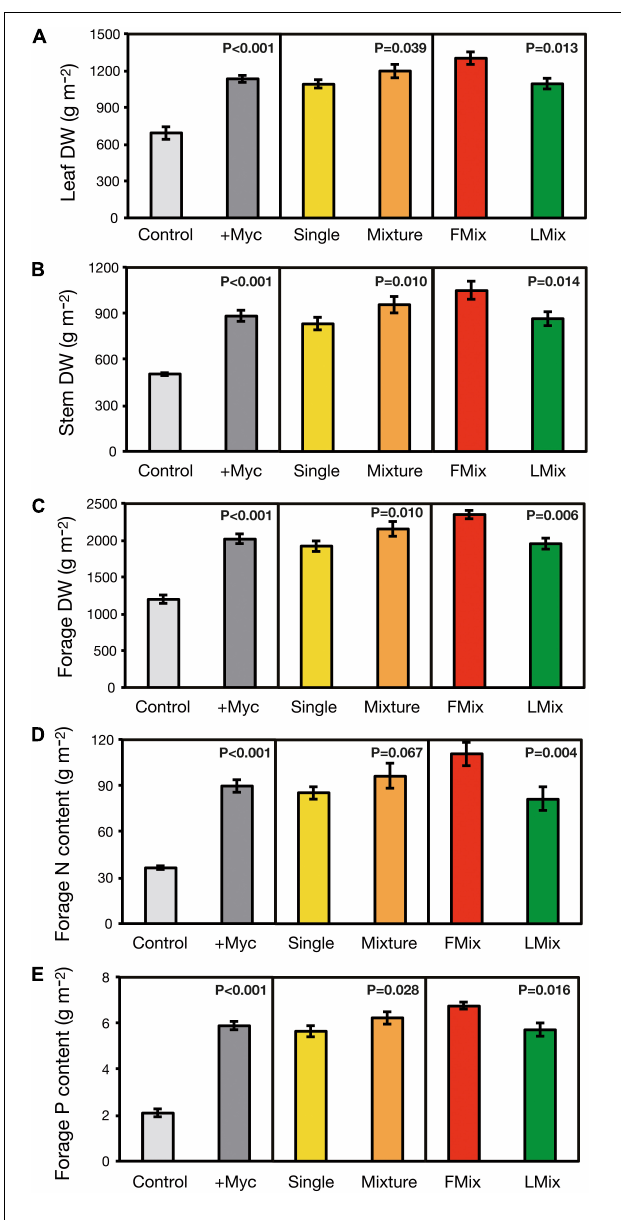
FIGURE 2 | Leaf, stem, and forage dry weight (A–C) of alfalfa ( M. sativa ), and forage nitrogen (N) and phosphorus (P) content (D,E) accumulated over years and cuts as affected by AM fungal inoculation. Results of orthogonal contrasts used for discriminating the differences between means: inoculated (+ Myc) vs. control, single fungal isolates vs. mixture inoculants (Single vs. Mixture), and foreign vs. local AM fungal mixtures (FMix vs. LMix) [Inoculants: F. mosseae BEG12, F. mosseae AZ225C, R. irregularis BEG141, foreign mixture-FMix (BEG12, AZ225C, and BEG141), local mixture-LMix of 14 AM fungal species belonging to five families, and mock-inoculated control]. Data are mean ± SE (three plot replicates per inoculum